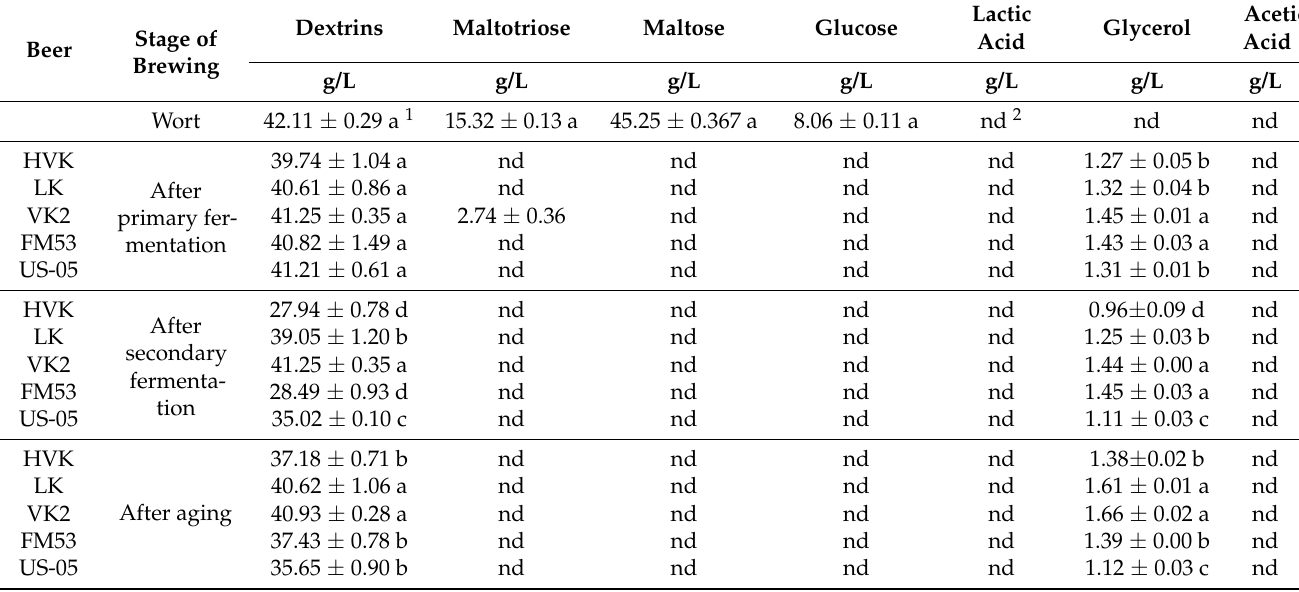
Table 2. Concentrations of carbohydrates and glycerol in the analyzed wort and